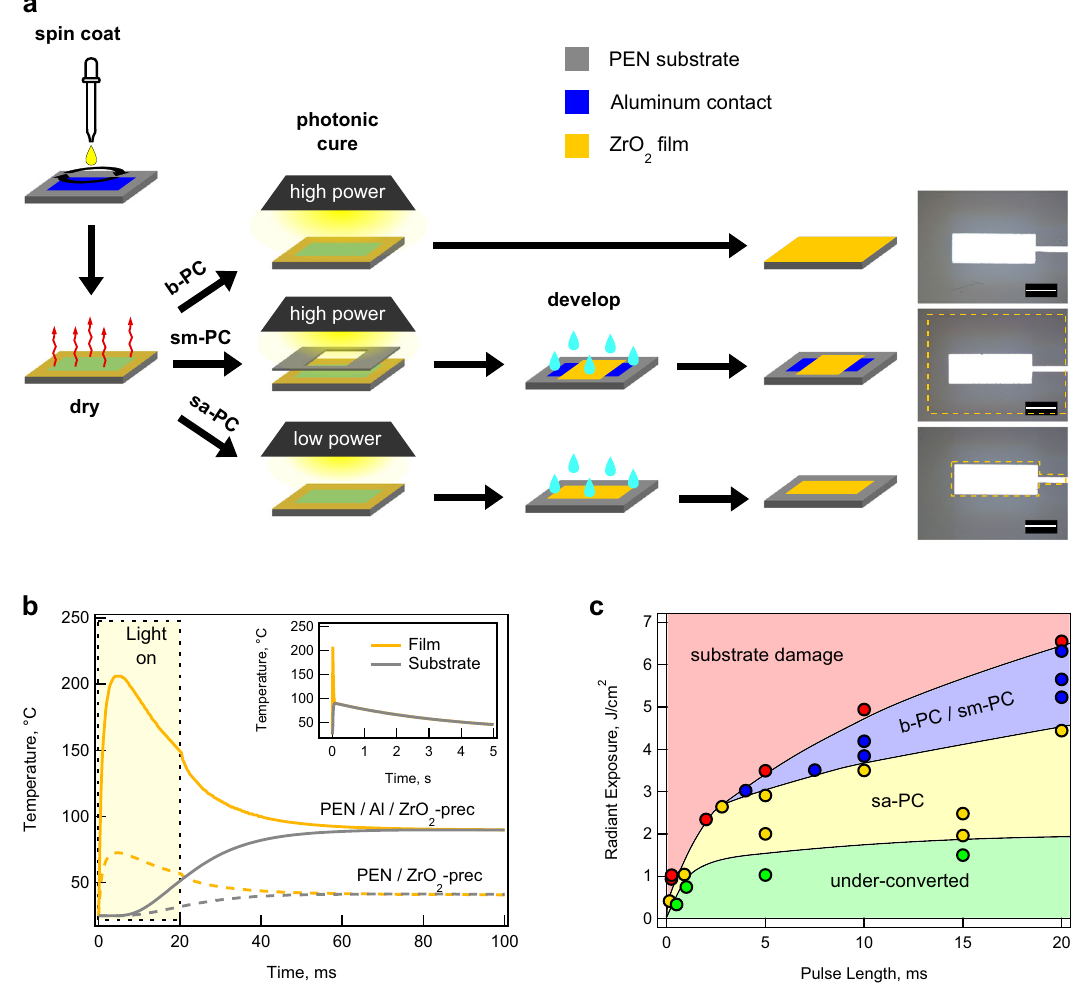
Fig. 1 Photonic curing process with three patterning modes. a Schematic of three photonic curing processes for forming ZrO 2 on PEN: blanket photonic curing (b-PC, top), shadow mask photonic curing (sm-PC, middle), and self-aligned photonic curing (sa-PC, bottom). The rightmost column shows optical images of each PC ZrO 2 fi lm on PEN with patterned Al bottom contacts. The borders of the patterned ZrO 2 fi lms are marked with orange dashed lines. Scale bars represent 500 µm. b Simulated fi lm (orange) and substrate (grey) temperatures versus time for a 20 ms light pulse on a ZrO 2 precursor fi lm deposited on top of Al contacts (PEN/Al/ZrO 2 -prec, solid lines) and directly on PEN (PEN/ ZrO 2 -prec, dashed lines) using measured data in Supplementary Fig. 1. Inset shows the temperature response of the sample on Al contacts over an extended (5 s) time frame. c Summary of photonic curing outcomes as a function of radiant exposure and pulse length. Conditions resulting in underconverted fi lms (green), sa-PC (yellow), b-PC/sm-PC (blue), and substrate damage (red) are marked with circles for measured conditions and shaded regions are exposure, an increase in pulse length results in a decrease in power delivery and higher surface temperatures of the sample. power. Figure 1c summarizes the results of photonic curing of Whether a pulse condition causes sample damage can be ZrO 2 fi lms on PEN as a function of the pulse length and simulated assessed after a single pulse. This is because the experimental radiant exposure. While we use simulated radiant exposure in this repetition rate used was 0.2 Hz, a much longer timescale (5 s) than plot, Supplementary Fig. 2 shows a close agreement between the pulse length (<20 ms); thus, the sample returns to thermal simulated and measured values for photonic curing conditions equilibrium with its surroundings between pulses (Fig. 1b, inset), used in this study. The pulse conditions that result in failure of the meaning that each repeated pulse is a thermally independent fi lm or substrate are shown in red. Two failure modes can occur: event. By increasing the pulse length or decreasing the radiant wrinkling of the fi lm and top surface of substrate 53 and cracking of exposure to avoid damage and move out of the red region of Fig. the fi lm. For a given radiant exposure, damage occurs if the pulse 1c, we move into the processing window for ZrO 2 shown in blue and yellow. In the blue region, the fi lm is converted independent length is too short. This is due to the higher power delivered by of whether it is on top of PEN or Al, making this region usable for the shorter pulse, resulting in higher temperatures at the top both b-PC and sm-PC processes. With a longer pulse length or surface of the sample and thermal expansion of the top surface of lower radiant exposure, only the ZrO 2 precursor on top of Al is the PEN. Longer pulses allow for heat transfer to the substrate converted, enabling sa-PC in the yellow region. Within the blue during the light pulse, which limits the temperature reached at the and yellow processing regions, repetition of pulses can increase sample surface such that damage does not occur. Similarly, for a the extent of conversion of the oxide fi lm, without inducing constant pulse length, an increase in the radiant exposure damage. Any further increase in pulse length or reduction in eventually results in damage to the substrate due to increased